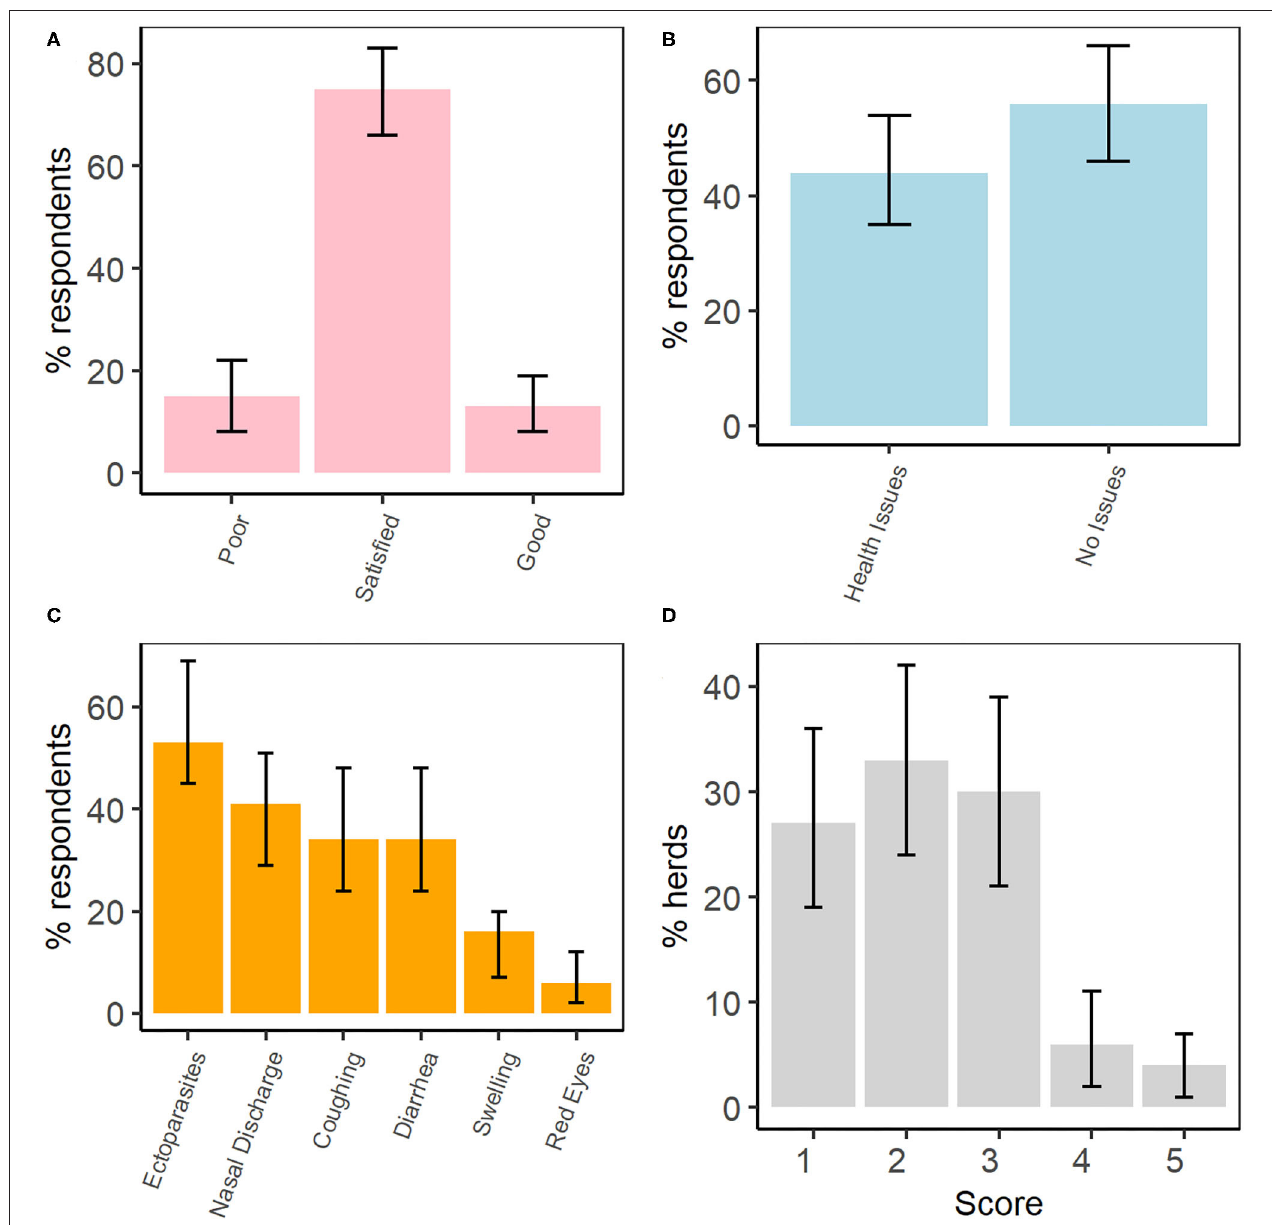
FIGURE 4 | Selected results from the semi-structured interviews, including (A) livestock health perception, (B) reported presence of health problems in livestock, (C) list of health issues and symptoms in livestock, and (D) the averaged composite five-point check scores for livestock in each herd ( n confidence intervals are interpreted as being statistically